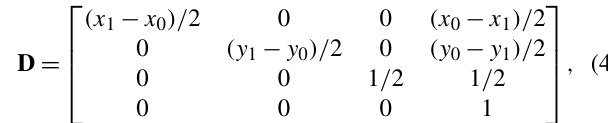
Figure 5. Sample rendering of the swissALTI 3D digital elevation model (DEM) using a pinhole camera model. DEM data © swis- stopo.